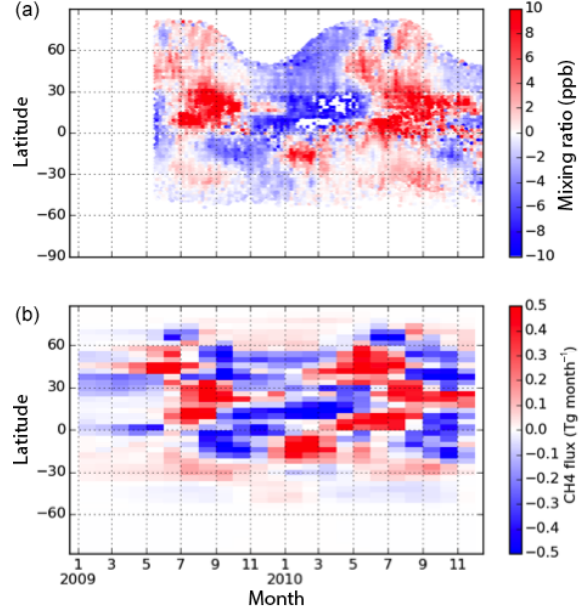
Figure 6. (a) Zonally averaged differences in CH 4 column mix- ing ratio between the two XCH proxy (b) Corresponding differences in a posteriori CH 4 flux between the proxy inversions using these data (PR-MA minus PR-CT).